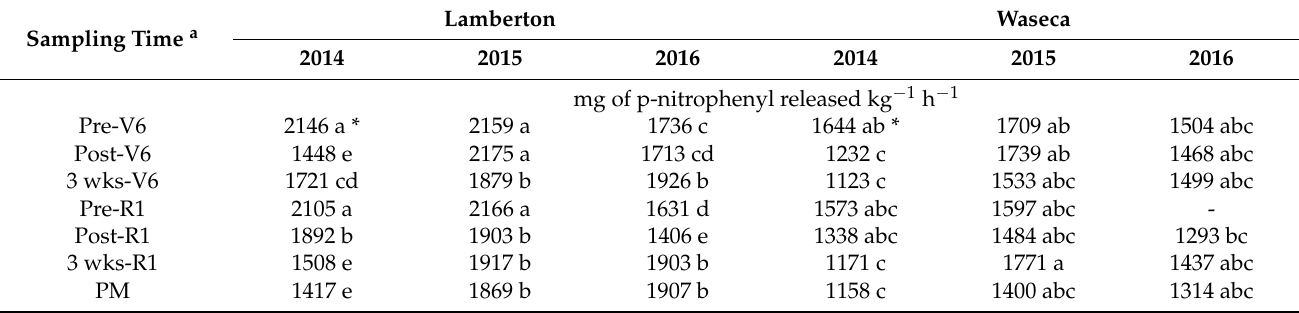
Table 6. In-season acid phosphatase activity across treatments at Lamberton and Waseca from 2014 to